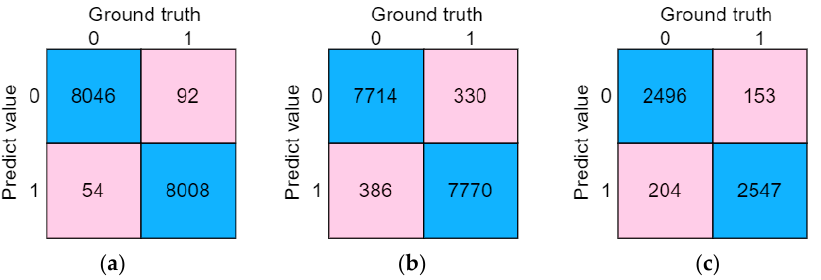
Figure 11. ( a ) Confusion matrix of the test set; ( b ) Confusion matrix of the robustness verification experiment; ( c ) Confusion matrix of the reliability verification experiment.